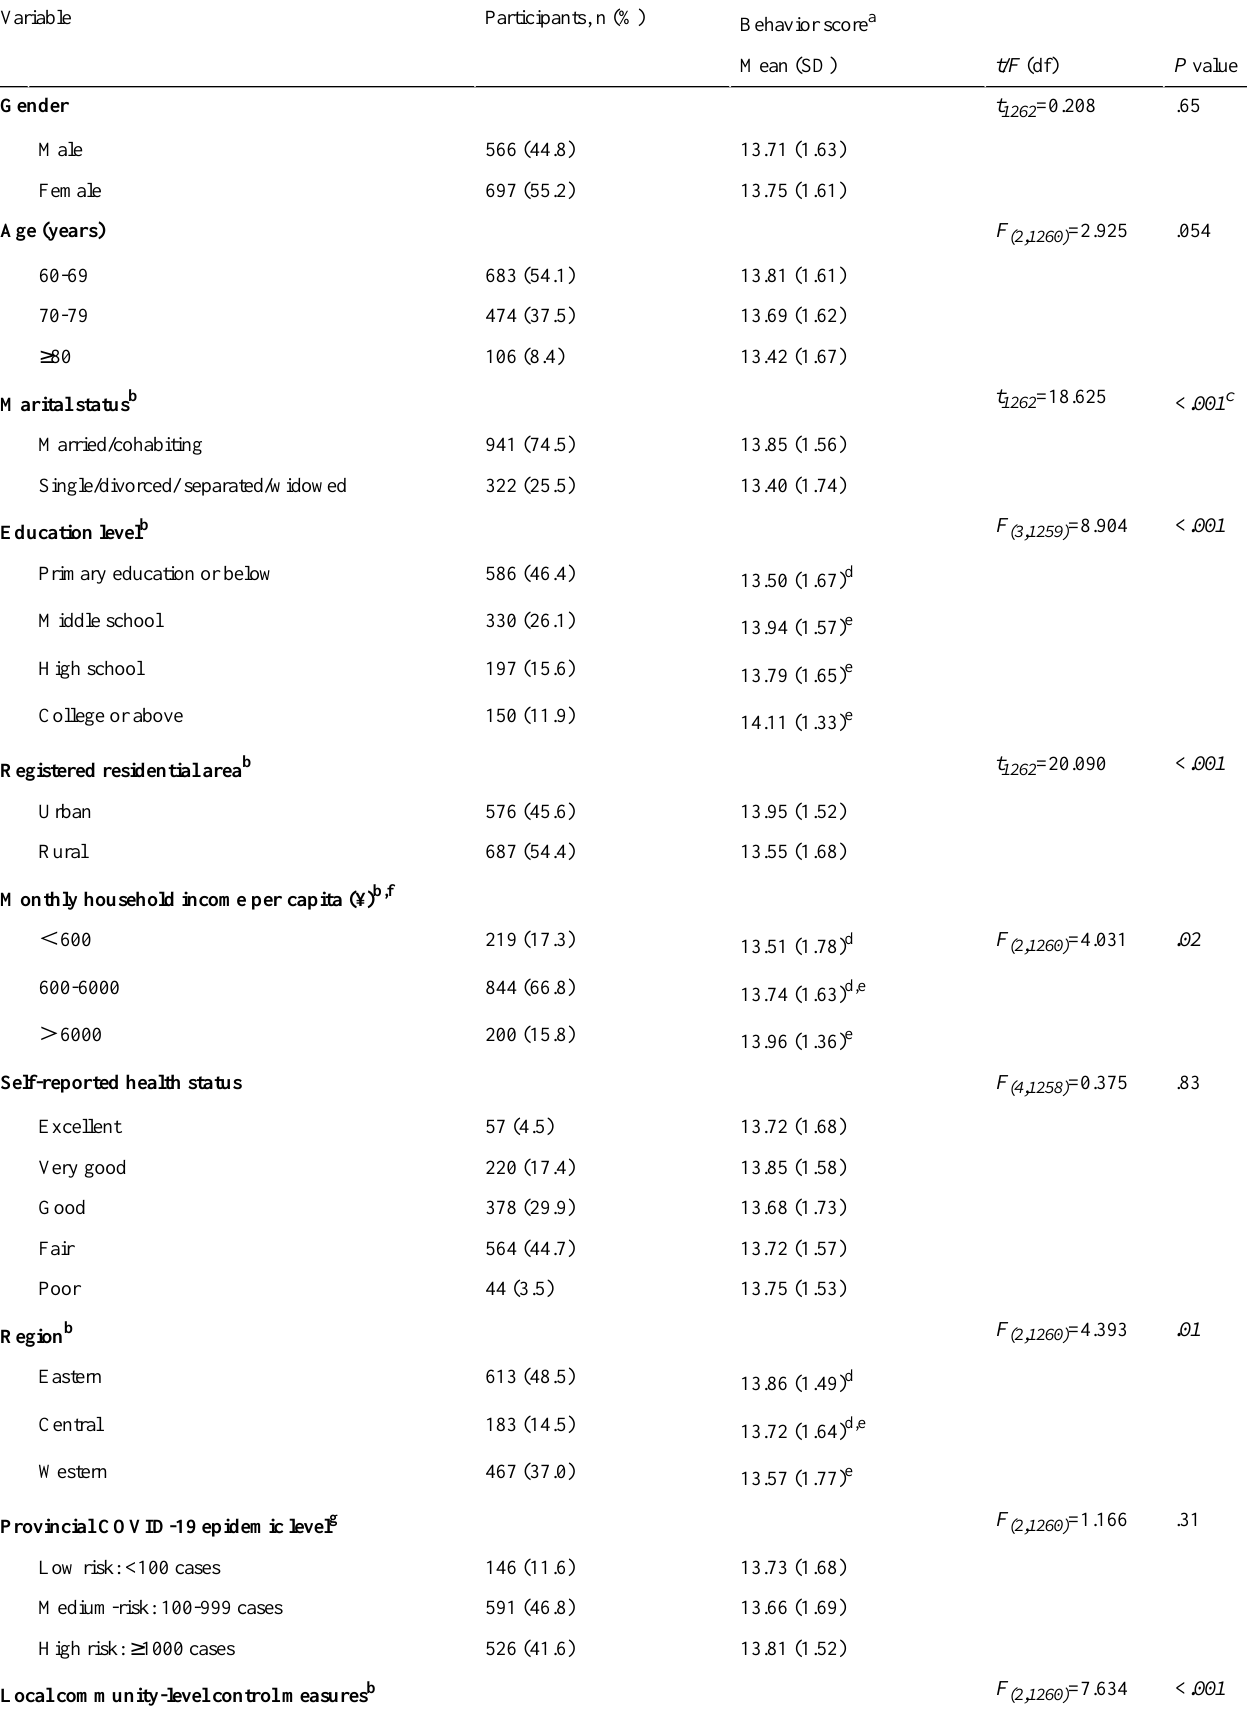
Table 3. Univariate analysis of the demographic variables associated with preventive behaviors